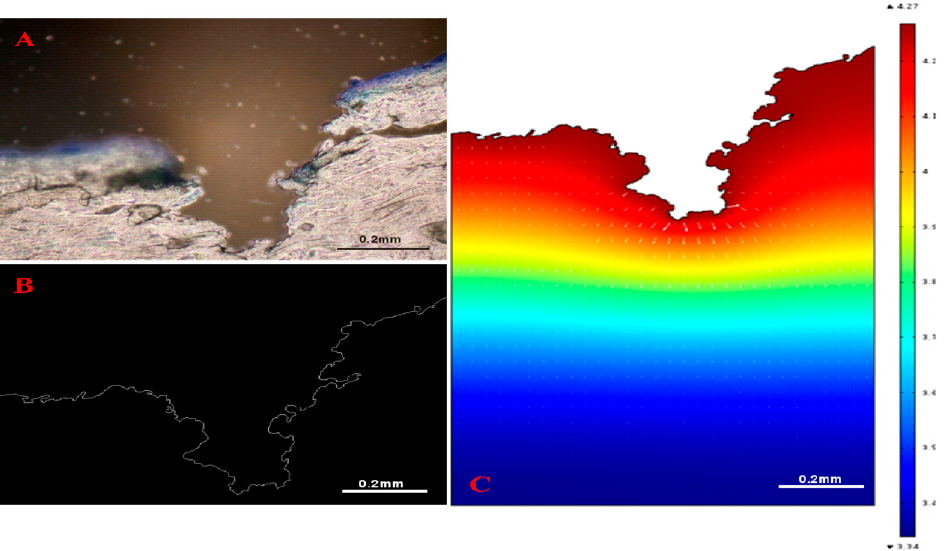
Figure 9. Relationship between the permeability and diffusion coefficient of the optimum solid (n = 20, R = 19 μ m and A = 0.04 cm 2 ) and hollow (n = 13, R = 140 μ m and A = 0.53 cm 2 ) MNs (adopted from [111]).